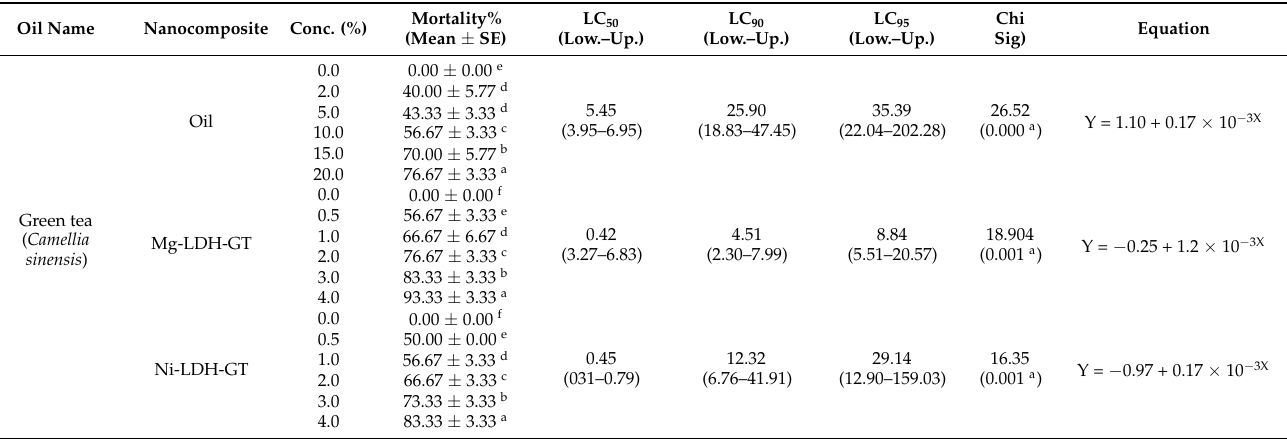
Table 6. The adulticidal effects of green tea oil and its LDH against adult Culex pipiens , 24 h post